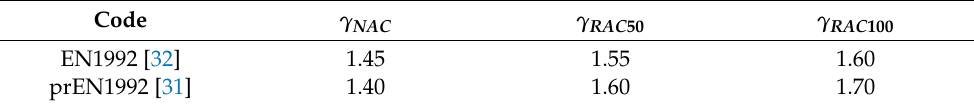
Table 2. Partial factors for elements without shear reinforcement used in the first iteration of the calibration procedures [24].